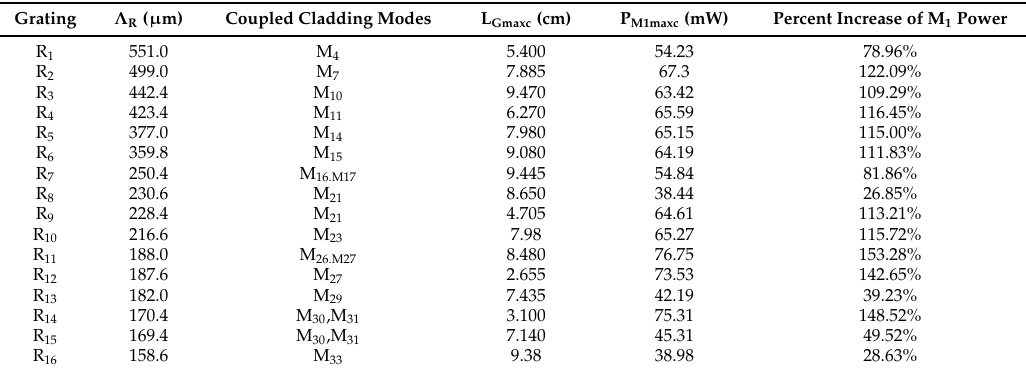
Table 4. Gratings maximizing the power exchange from the inner cladding modes M 2 -M 33 towards the fundamental core mode M 1 at the environmental temperature 25 ˝ C.